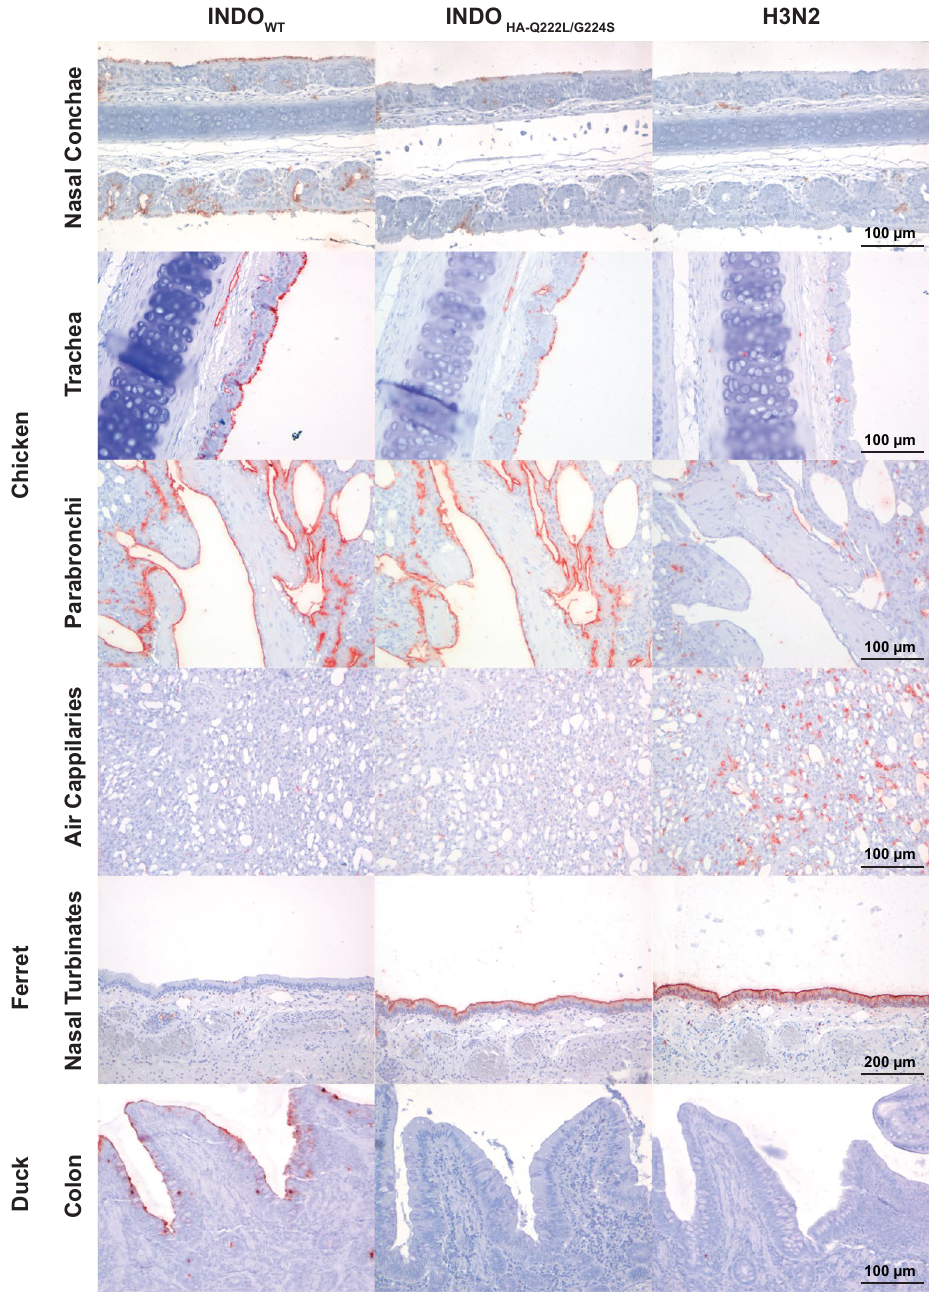
Figure 4. Attachment of INDO HA-Q222L/G224S to different parts of the upper and lower chicken respiratory tract. The attachment of a human seasonal influenza virus A/H3N2 (A/Netherlands/213/2003) and of INDO WT is shown for comparison. Every part of the chicken respiratory tract expresses both α .2,3-SA and α .2,6-SA. Attachment to ferret nasal turbinates and duck colon, which expresses α .2,6-SA and α .2,3-SA respectively, is shown as control for binding of human and avian influenza A viruses